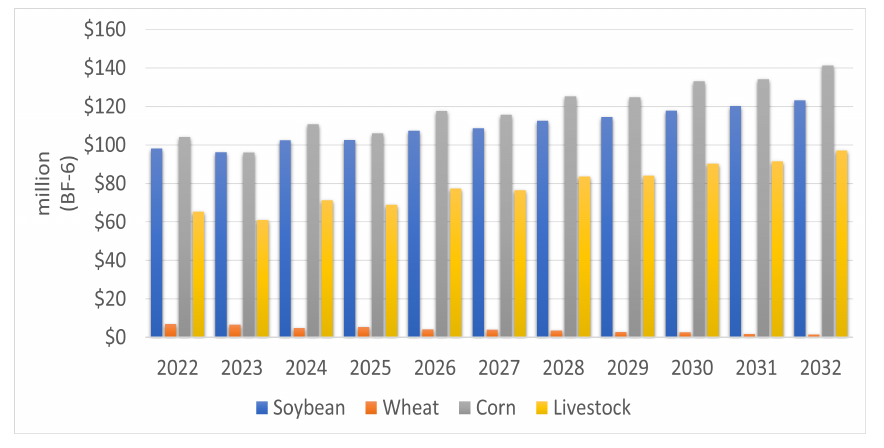
Figure 6. Cost savings in agriculture (BF-6; see Section 4.6).